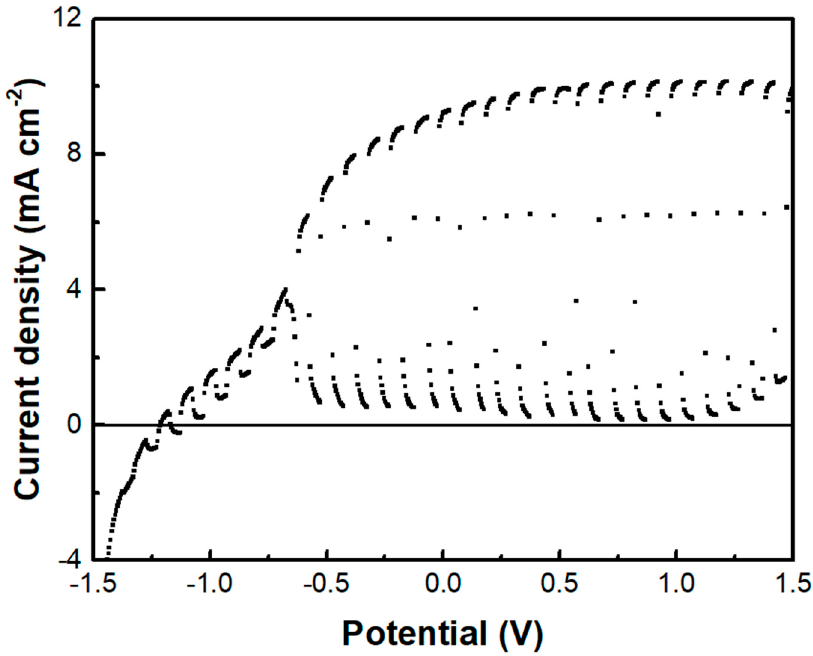
Figure 9. The current density-voltage curve was recorded in the light chopping mode using the BC electrode as a cathode.